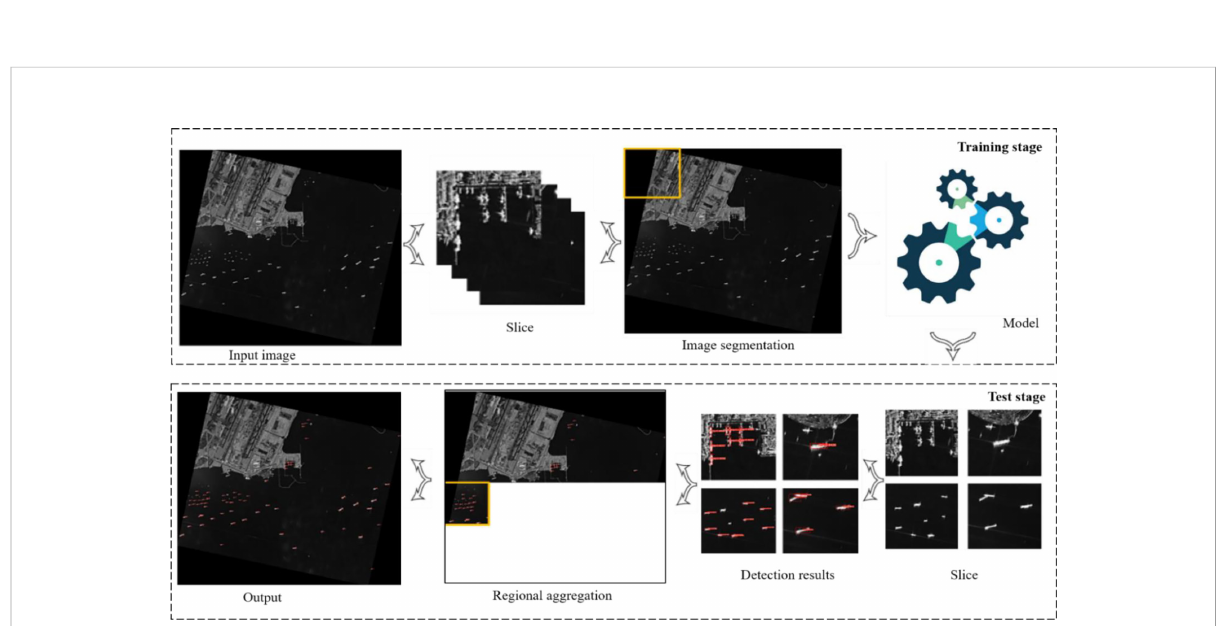
FIGURE 14 Ship target identi fi cation Framework in a SAR large scene images.